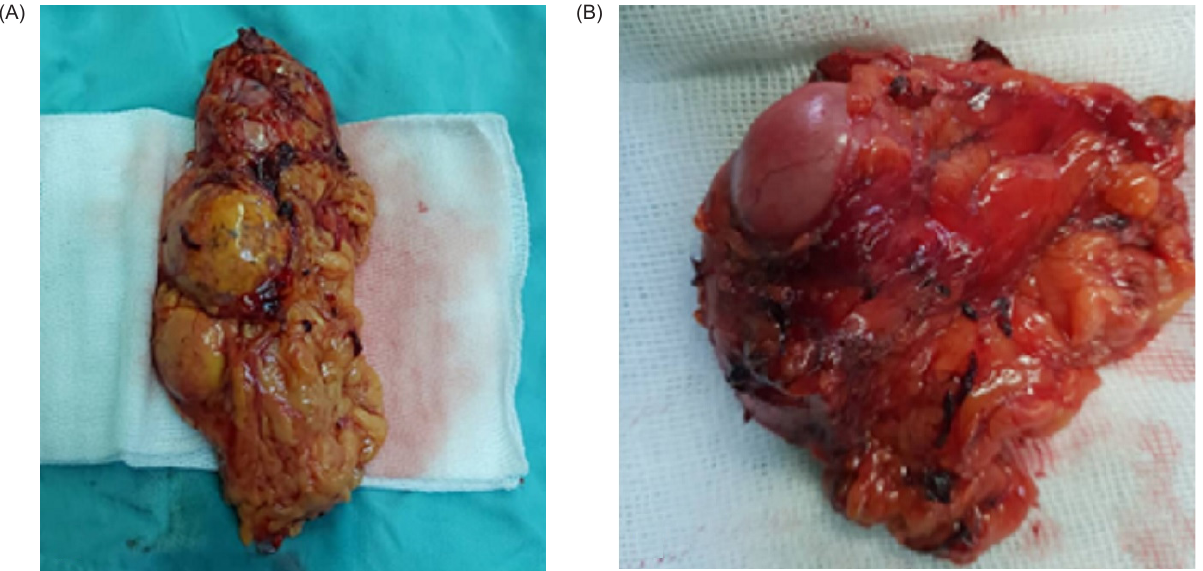
Figure 2: Postoperative photo of the masses. (A) Right adrenal gland. (B)Left adrenal gland).